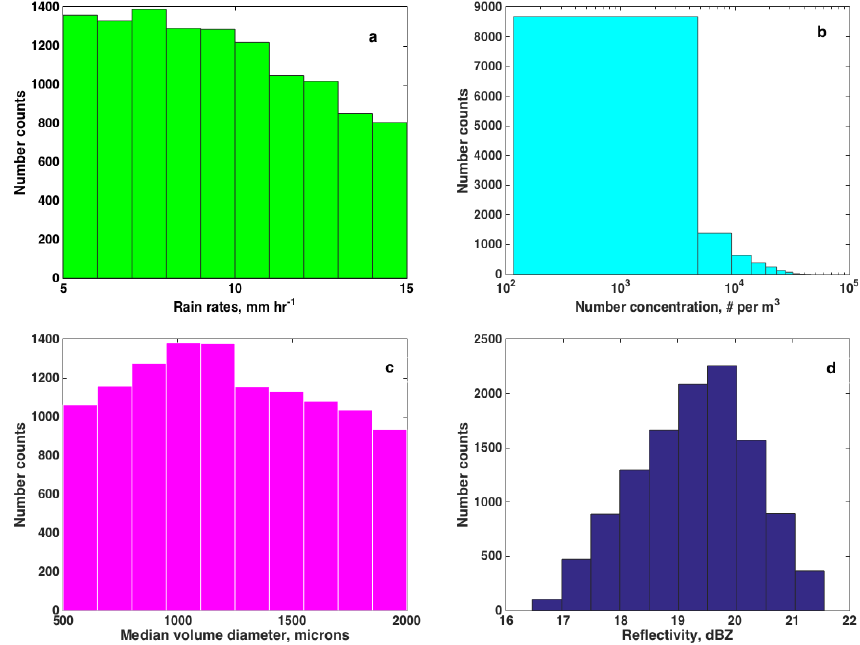
Figure 8. Histograms of rain rates, raindrop size distributions and computed W-band reflectivities: (a) rain rate, (b) concentration, (c) median volume diameter, and (d) reflectivity. Mean value of reflectivity is 19dBZ and standard deviation is less than dB for rain rates between 5 and 15mmh − 1